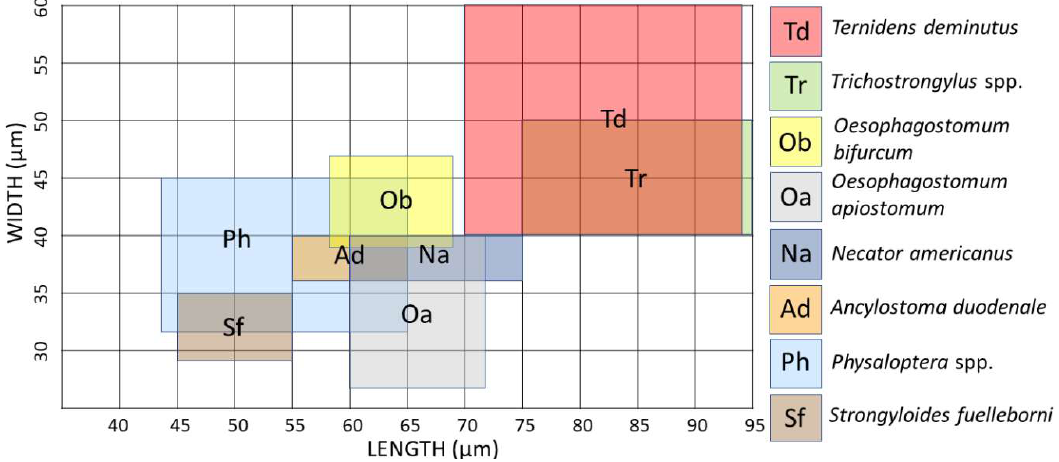
Figure 3. Size range comparison chart of hookworm-like eggs passed in human feces [21,40–42].